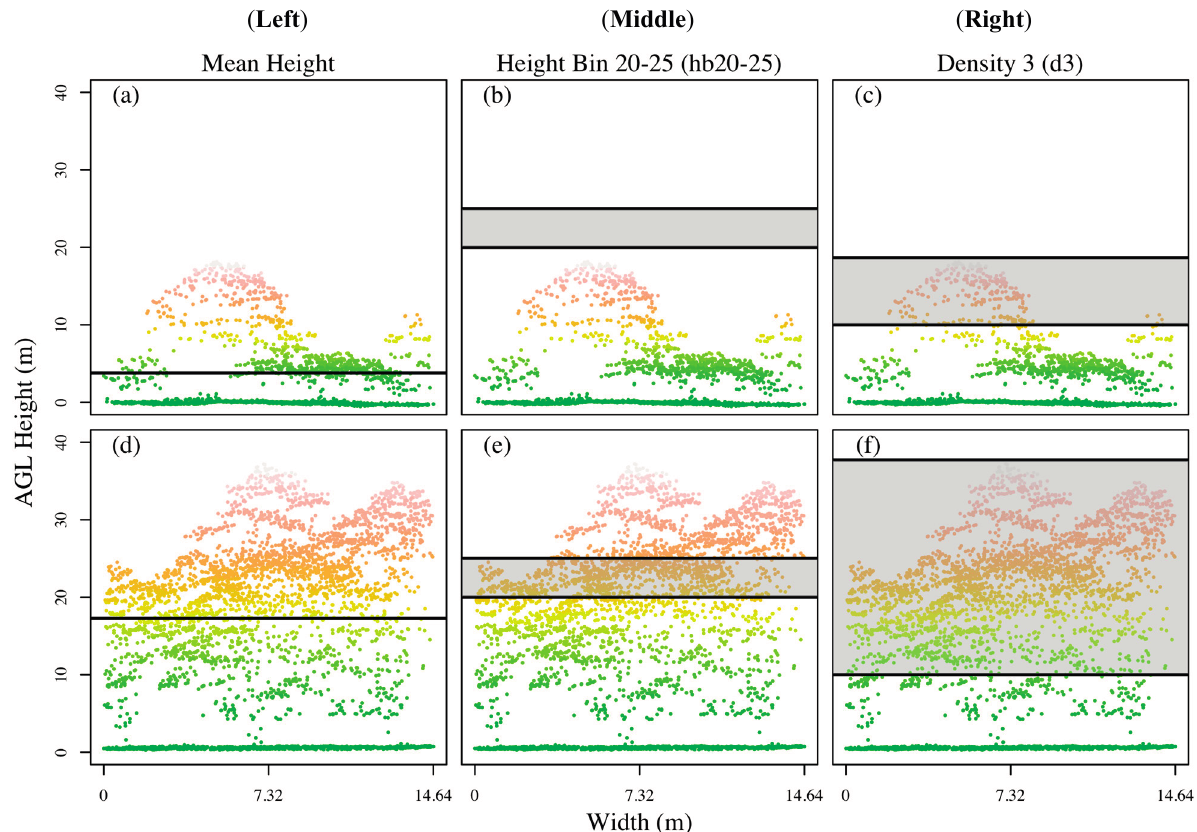
Figure 9. Cross-sectional plots of two subplot point clouds displaying the location of the best aboveground biomass and gross volume predictor variables. The left subfigures identify the mean height for each example subplot. The middle subfigures identify the location of height bin 20-25 for each example subplot. The right subfigures identify the location of density 3 for each example